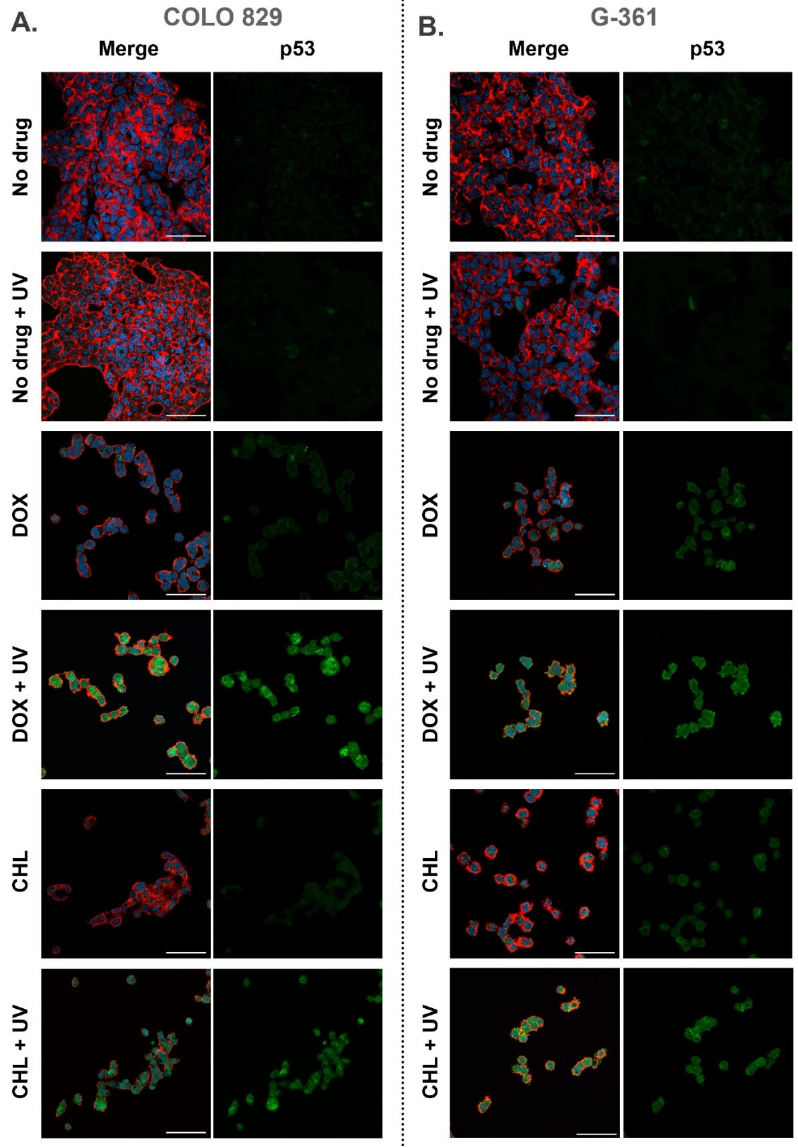
Figure 6. Confocal imaging of COLO 829 ( A ) and G-361 ( B ) melanotic melanoma cells treated with doxycycline and chlortetracycline and exposed to UVA radiation. The figure present merged images (nuclei—blue, actin cytoskeleton—red, and p53—green) as well as the separate channel visualizing p53. Scale bar 50 µ